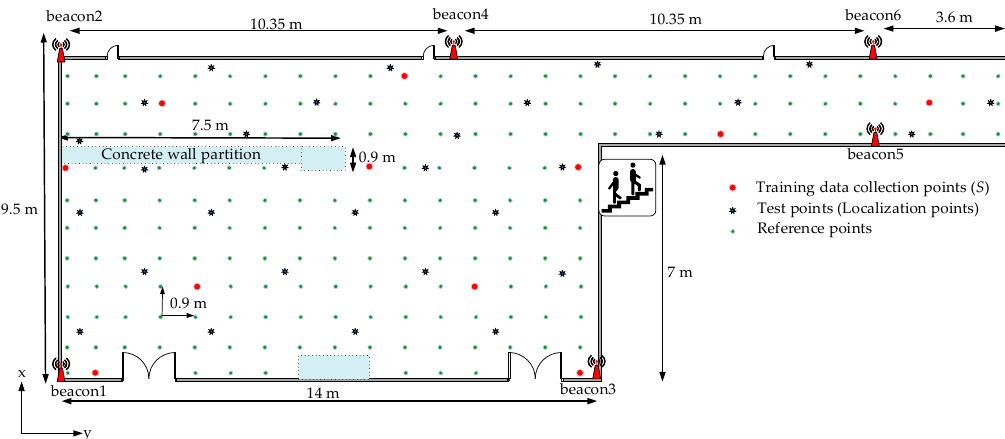
Figure 2. Graphical representation of the testbed (A hallway at the IT building in Chosun University, Korea).